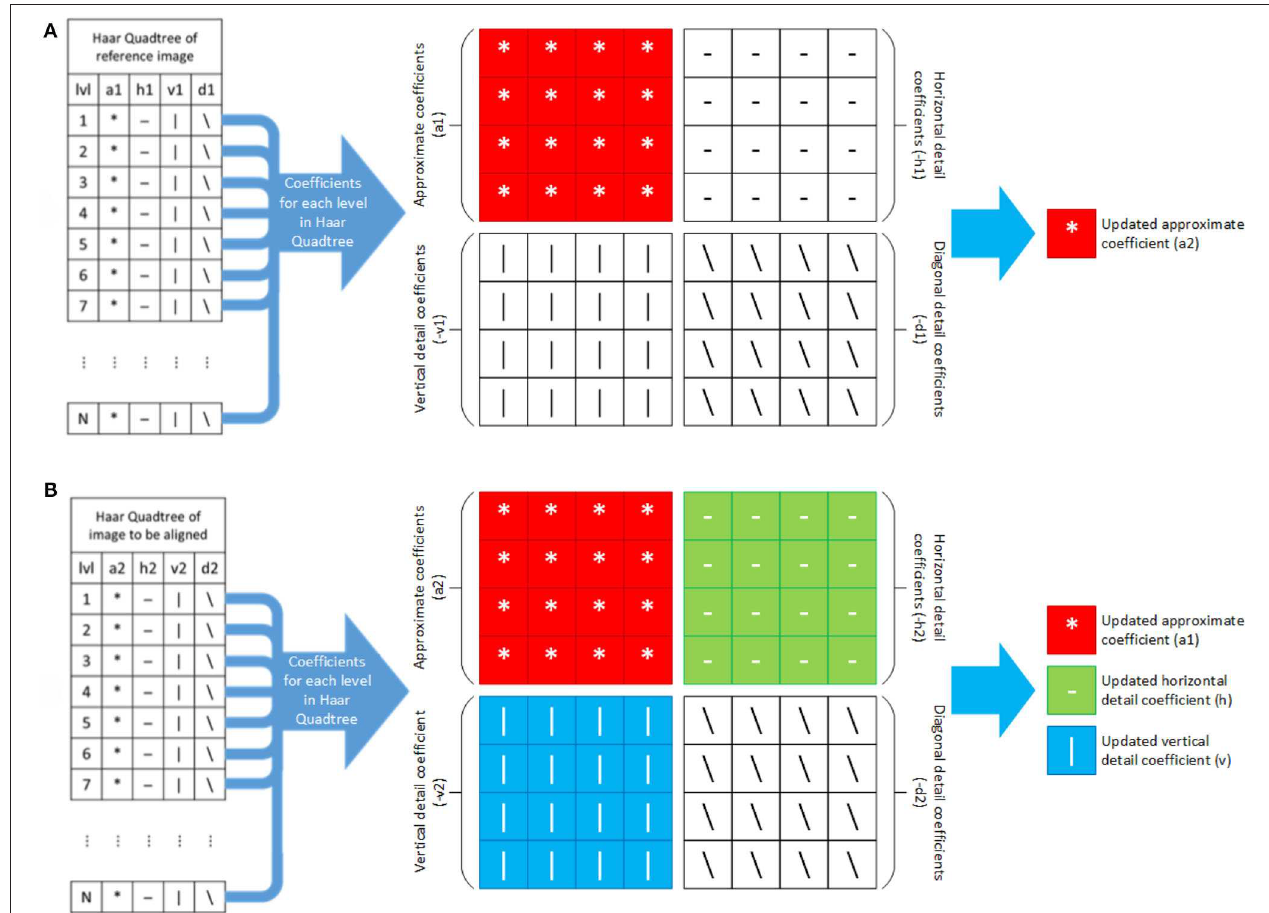
FIGURE 7 | Updating Haar wavelet coefficients for each level in Haar quadtree of (A) reference and (B) image to be